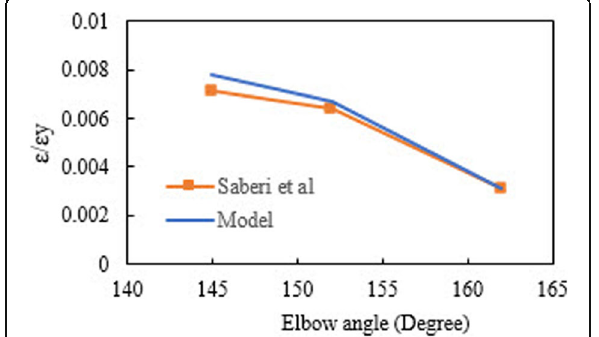
Fig. 18 Effect of elbow angle on strain ratio (comparison with Saberi et al. 2015)